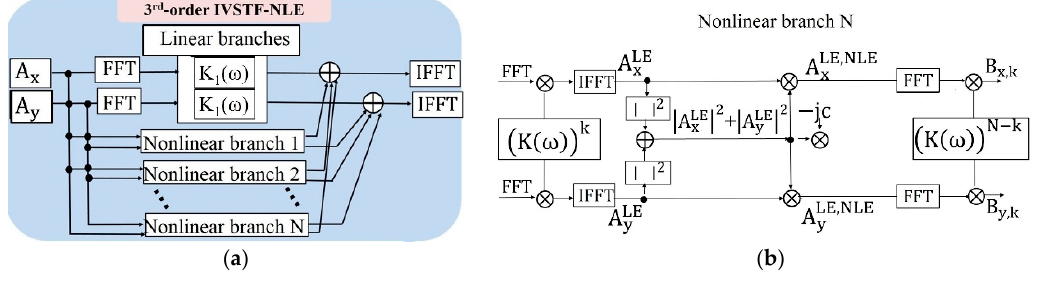
Figure 1. ( a ) Block diagram of the 3rd-order IVSTF-NLE; ( b ) Operating principle of the kth nonlinear compensation branch of the 3rd-order IVSTF-NLE [16]. (Symbols: Inverse Fast Fourier Transform (IFFT), Linearly Equalized (LE), Non-Linearly Equalized (NLE), Fast Fourier Transform (FFT)).